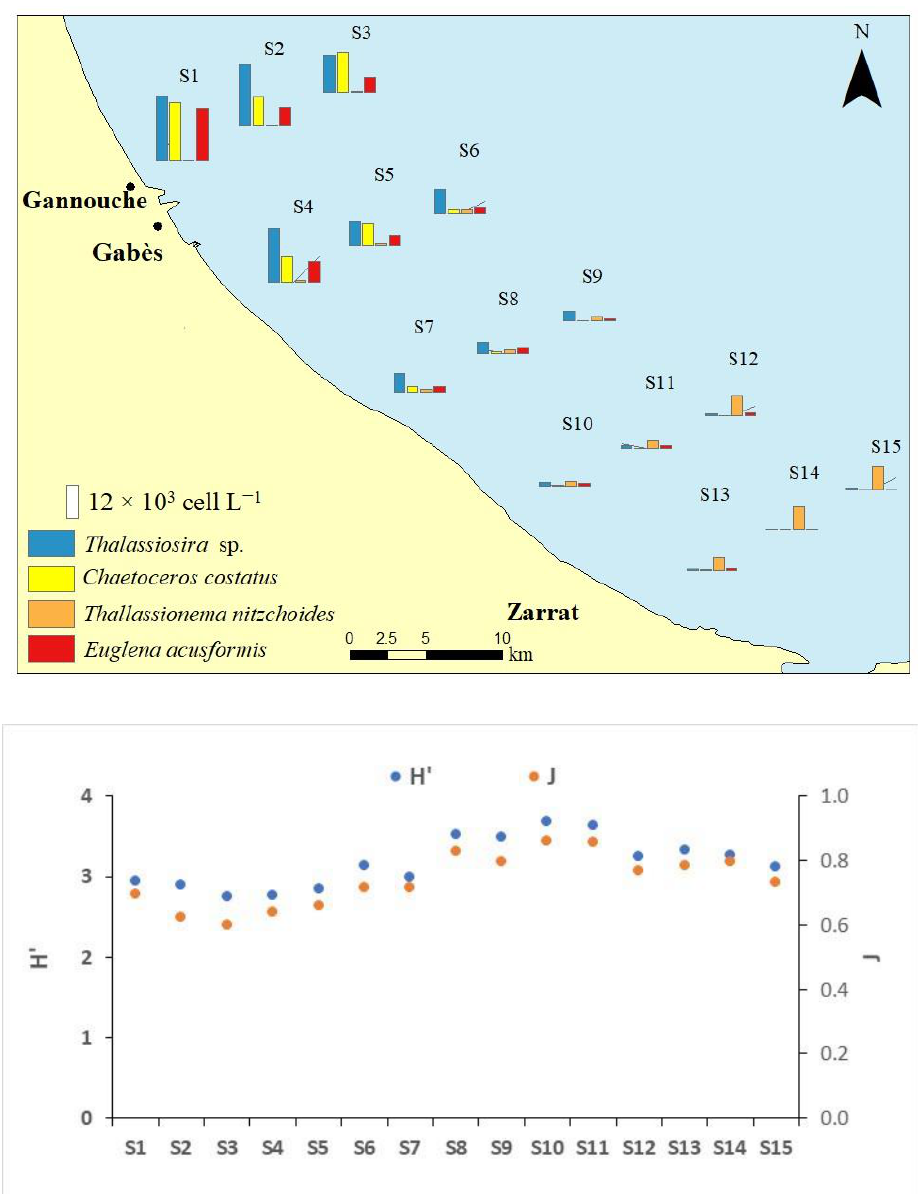
Figure 6. Spatial abundance of most important phytoplankton taxa (number beside the bar indicates scale of abundance) ( top ) and diversity indices (H’ and J) ( bottom